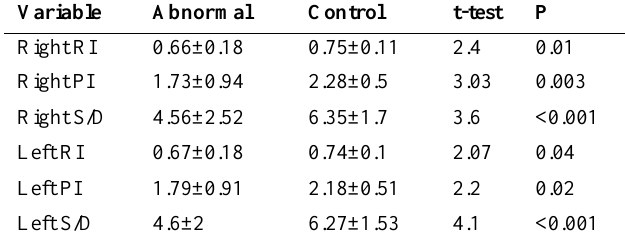
Table 1: Mean levels of uterine artery parameters between women with abnormal pregnancy and